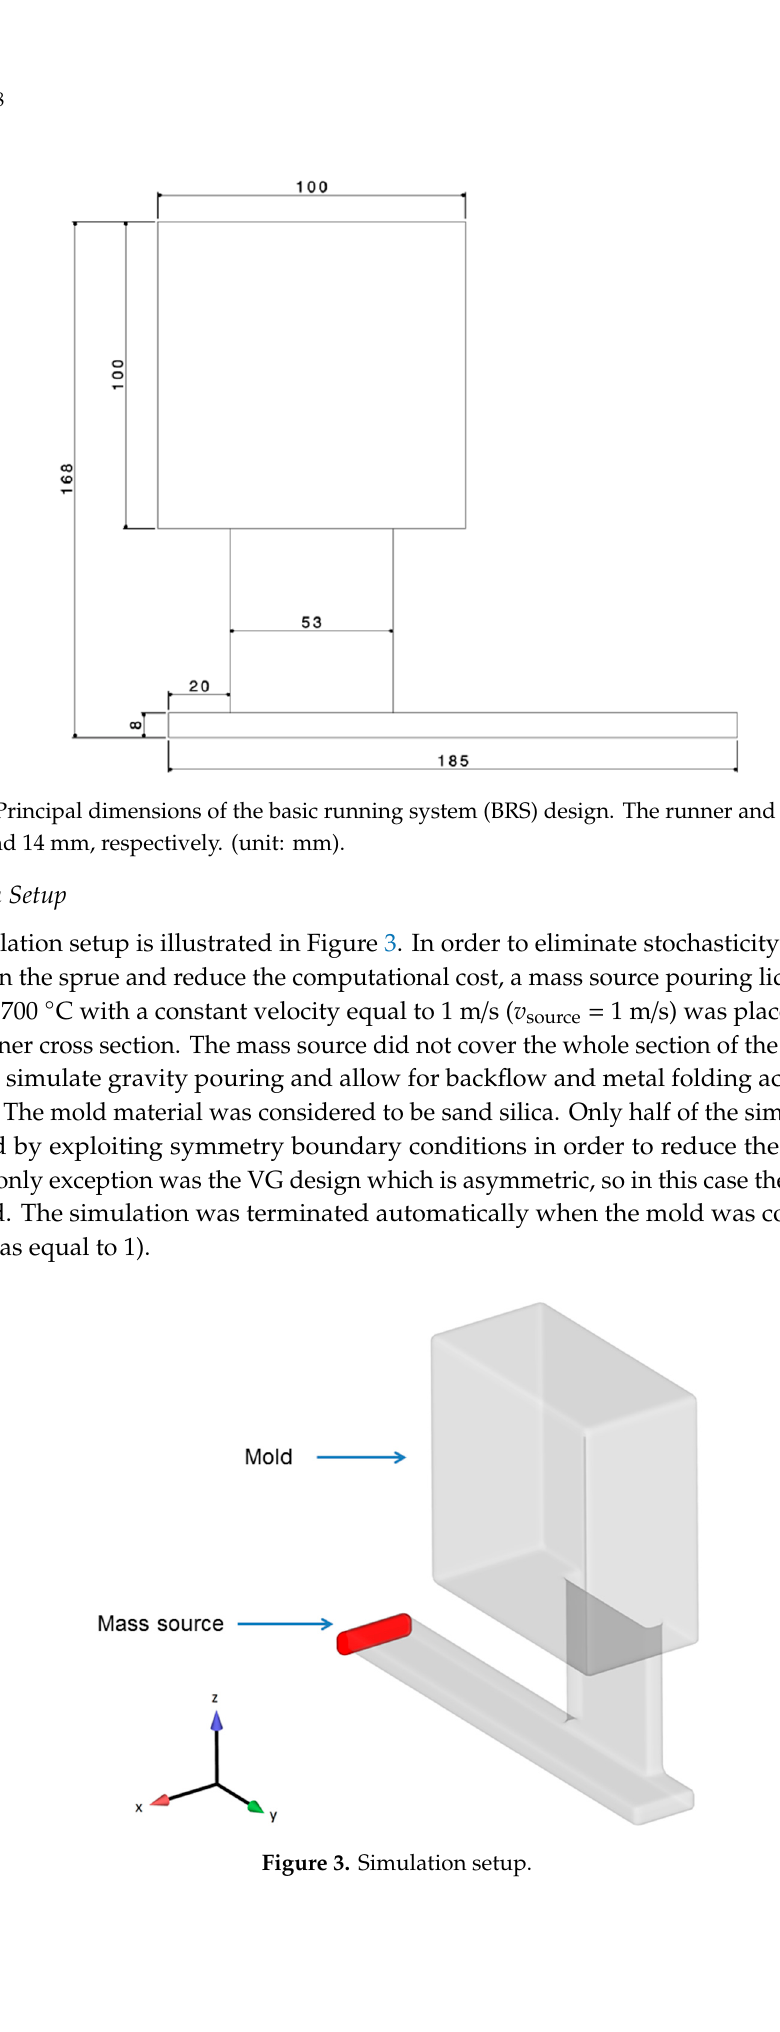
Figure 3. Simulation setup. A hexahedral mesh with a cell size equal to 1.5 mm was utilised for solving the mass, momentum, and energy conservation equations. The cell size was selected so as to ensure that at least three cells expand across the thinnest cross section of the casting located at the runner (see Figure 2).